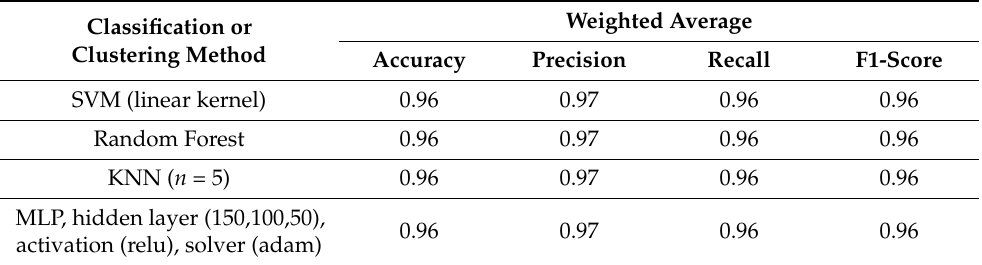
Table 7. Performance of different algorithms for RSSI_TAG2 data.